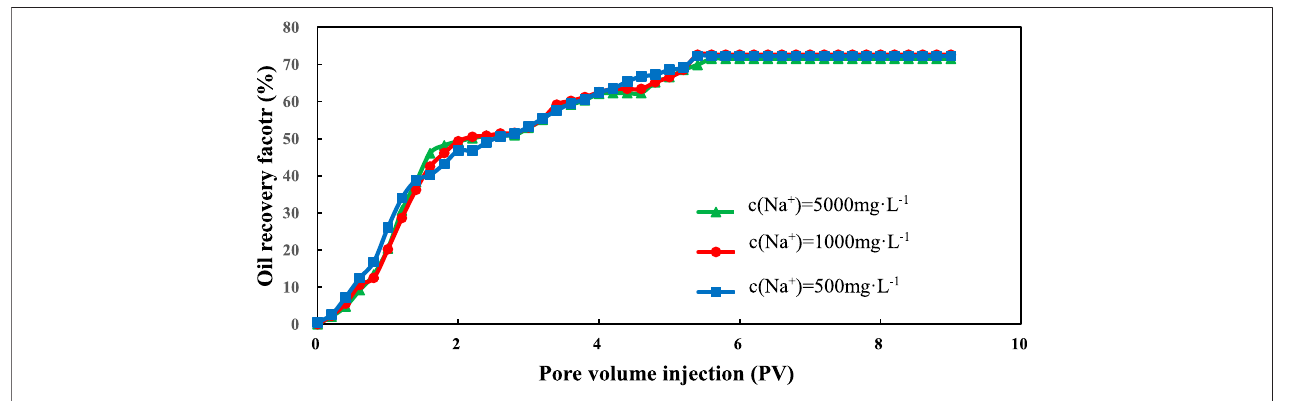
Frontiers in Energy Research |